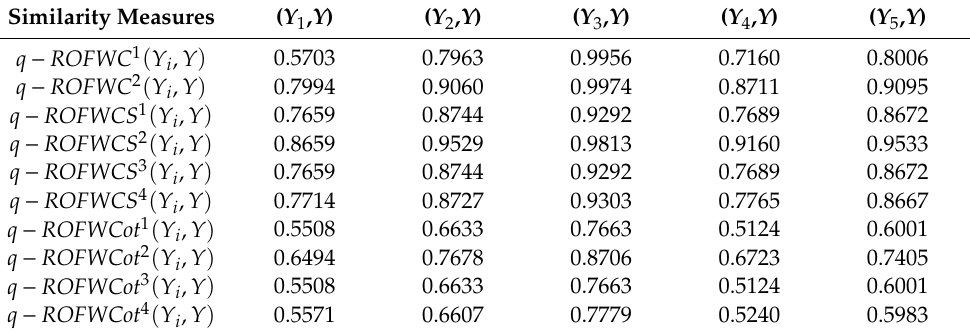
Table 5. The weighted similarity measures between Y i ( i = 1,2,3,4,5 ) and Y + .